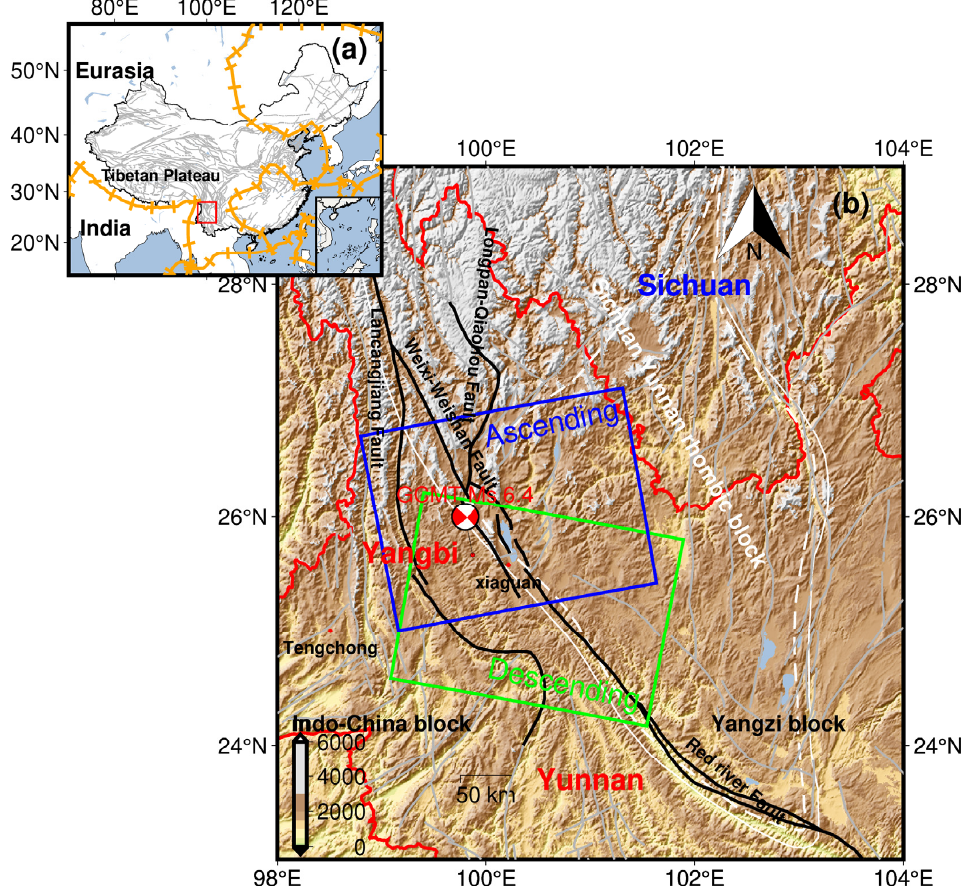
Figure 1. ( a ) Location of Yangbi and the surrounding region (red box) in China. The orange line represents the plate boundary. ( b ) Indicates the specific study area. The red beach ball diagram represents the focal mechanism of the Ms 6.4 (GCMT) Yangbi earthquake in 2021. Black lines and grey lines indicate active faults [18]. The blue and green boxes are the coverages of the Sentinel-1A ascending and descending images, respectively. The red line indicates the Yunnan provincial boundary. The rhombic block enclosed by the white dotted line is the Sichuan-Yunnan rhombic block.